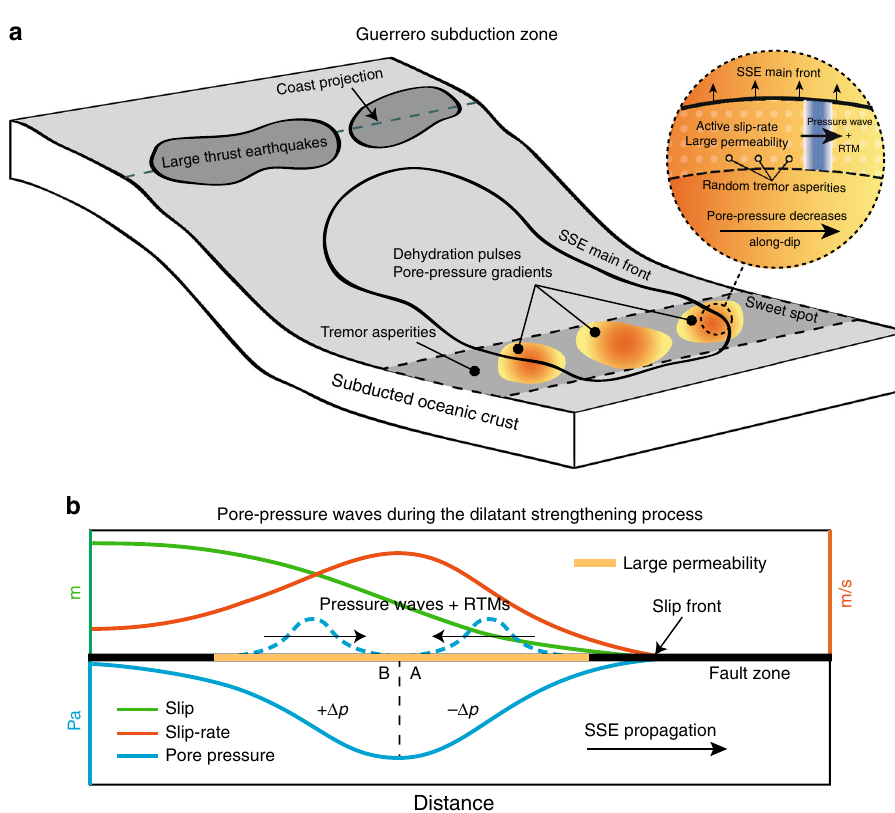
Fig. 5 Cartoons illustrating the mechanisms we propose to explain the existence of pore-pressure waves in the plate interface and the associated generation of RTMs. a The Cocos plate interface during a SSE experiences a RTM due to the propagation of a pressure wave and thus a SSF, which is driven by a preexistent ∇ p 0 associated with a localized dehydration pulse in the oceanic crust. A highly permeable zone associated with the active SSE front channelizes the wave. This mechanism is likely to explain RTMs following the SSE front (e.g., tremor streaks). b Plate interface conditions set by the dilatant strengthening mechanism during a SSE. Two opposite pore-pressure gradients are generated in the SSE front-perpendicular direction where permeability is increased. This mechanism is likely to explain both the rapid tremor reversals (RTRs) and RTMs in the SSE propagation